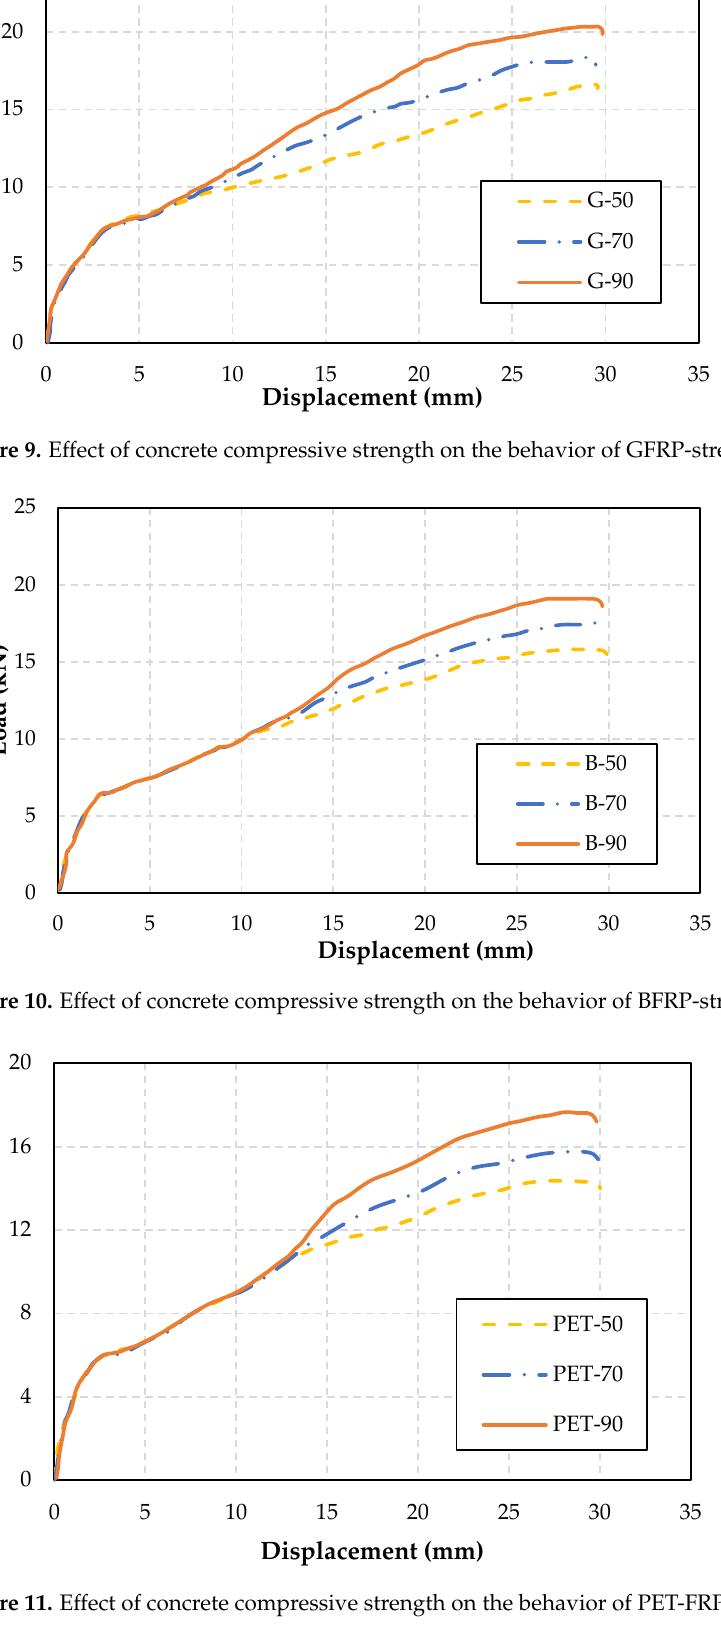
Figure 11. Effect of concrete compressive strength on the behavior of PET-FRP-strengthened slabs.